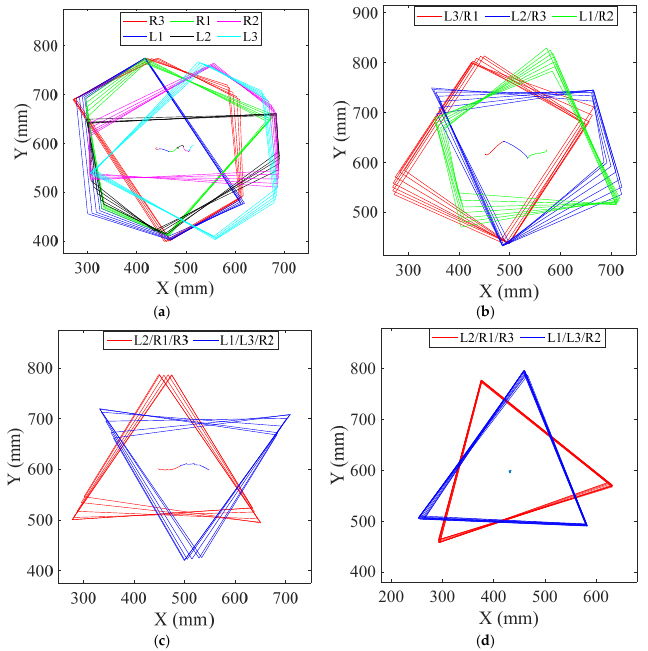
Figure 12. The stability margin of four different gaits within a single motion period: ( a ) the wave gait; ( b ) the tetrapod gait; ( c ) the tripod gait; ( d ) the self ‐ turning gait.